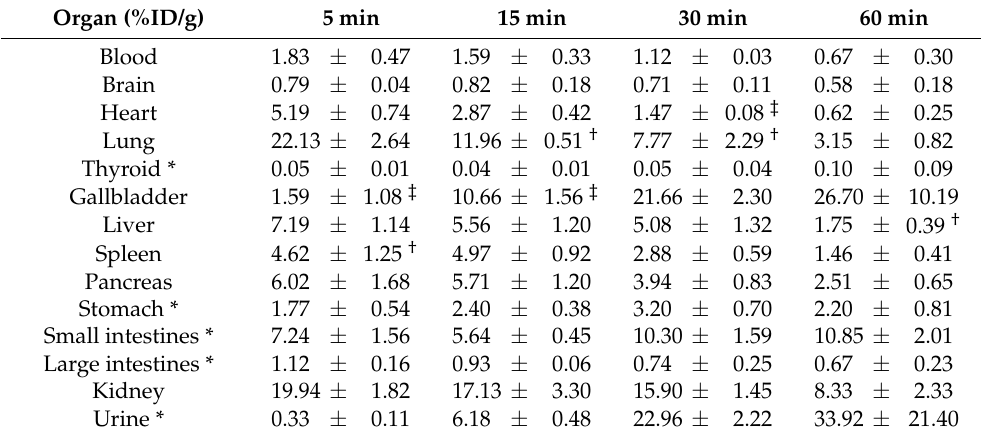
Table 3. Biological distribution of 125 I-ODV and metabolite of 125 I-ODV (CYP2D6